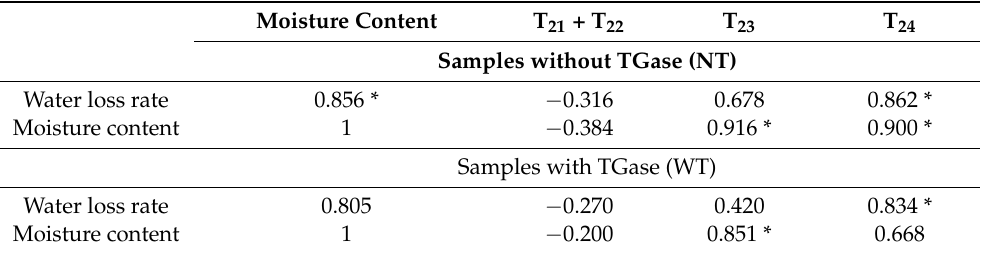
Figure 2. Effect of different thermal treatment methods and the addition of TGase on the microstruc- ture of D. maruadsi surimi products. BOI: boiled D. maruadsi surimi products; STE: steamed D. maruadsi surimi products; BAC: back-pressure sterilized D. maruadsi surimi products; ROA: roasted D. maruadsi surimi products; MIC: microwaved D. maruadsi surimi products; FRI: fried D. maruadsi surimi products; NT: group of without TGase; WT: group of with TGase. Table 2. Spectral peak areas of various water states in D. maruadsi surimi products. Table 3. T 2 relaxation peak areas of two D. maruadsi surimi products (NT and WT) under different thermal treatment